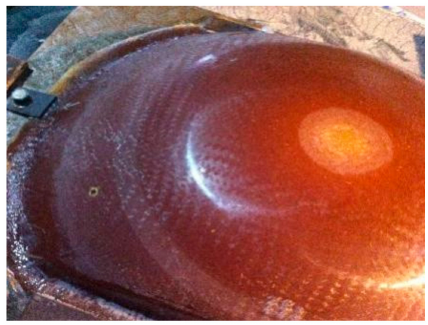
Figure 18. Grinding radome.